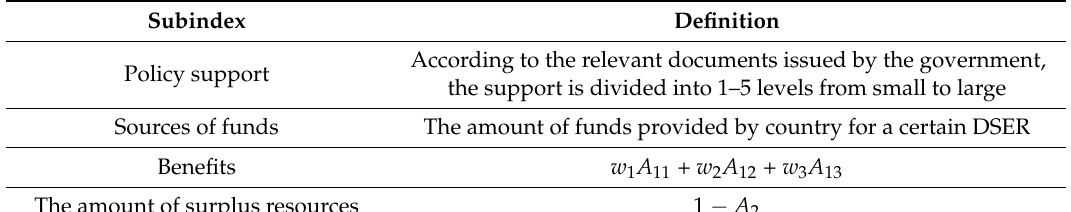
Table 2. Definition of development potential.